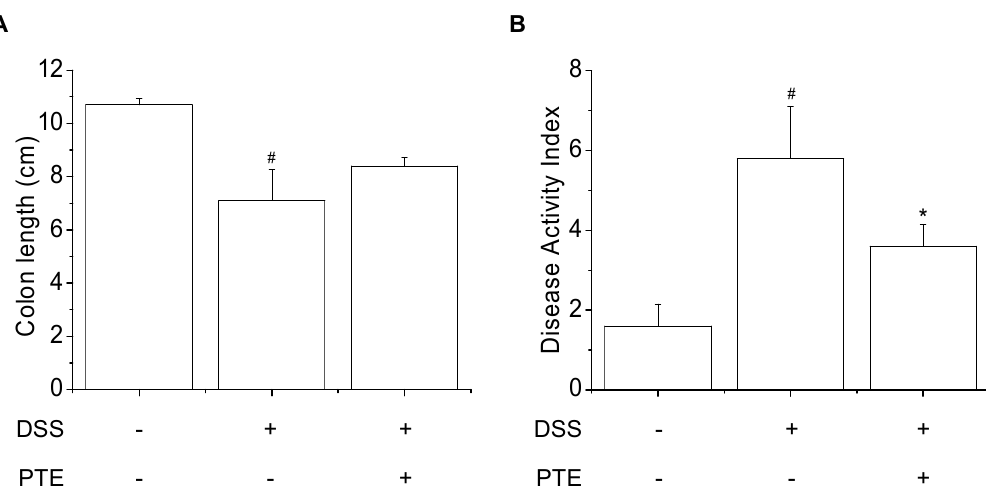
Figure 2. E ff ects of PT extracts on colitis development in DSS-treated mice. ( A ) Colon length in each group of the PT extracts treatments. Colon length was measured by ruler at the end of the experiment. ( B ) The disease activity index (DAI) score. The DAI is the sum of the three parameters such as body weight loss, stool consistency, and stool bleeding. All results are expressed as the means ± SD ( n = 10). Compared with Control group, # p < 0.05, Compared with DSS-treated group, * p < 0.05. Control, DSS, and PTE indicated normal group, DSS-treated group, and DSS plus PT extracts-fed group, respectively.